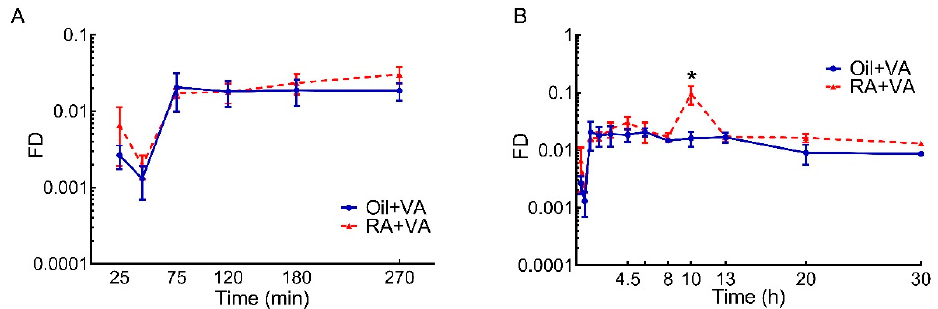
Table 1. Area under the curve (AUC) in RA-pretreated pups and CN pups, indicating higher intes- tinal VA mass accumulation in RA-primed pups in the later hours after VA supplementation.